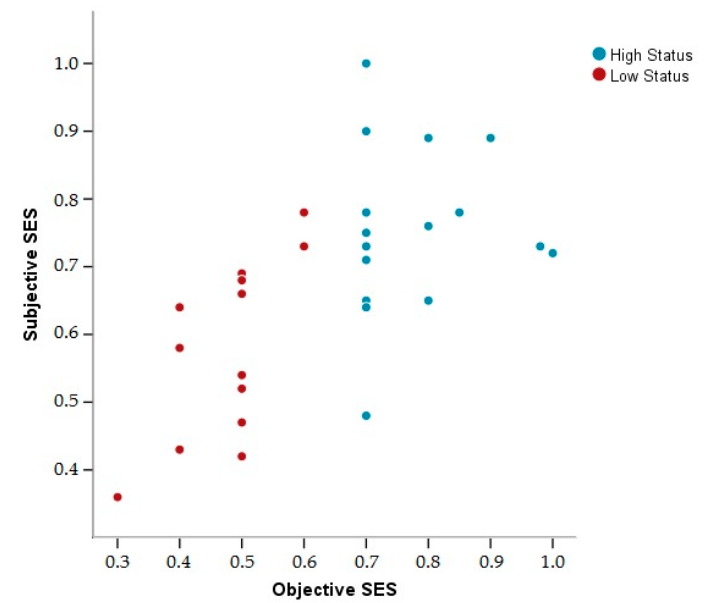
Figure 3. Scatterplot of the normalized objective and subjective socioeconomic status (SES) of the resulting